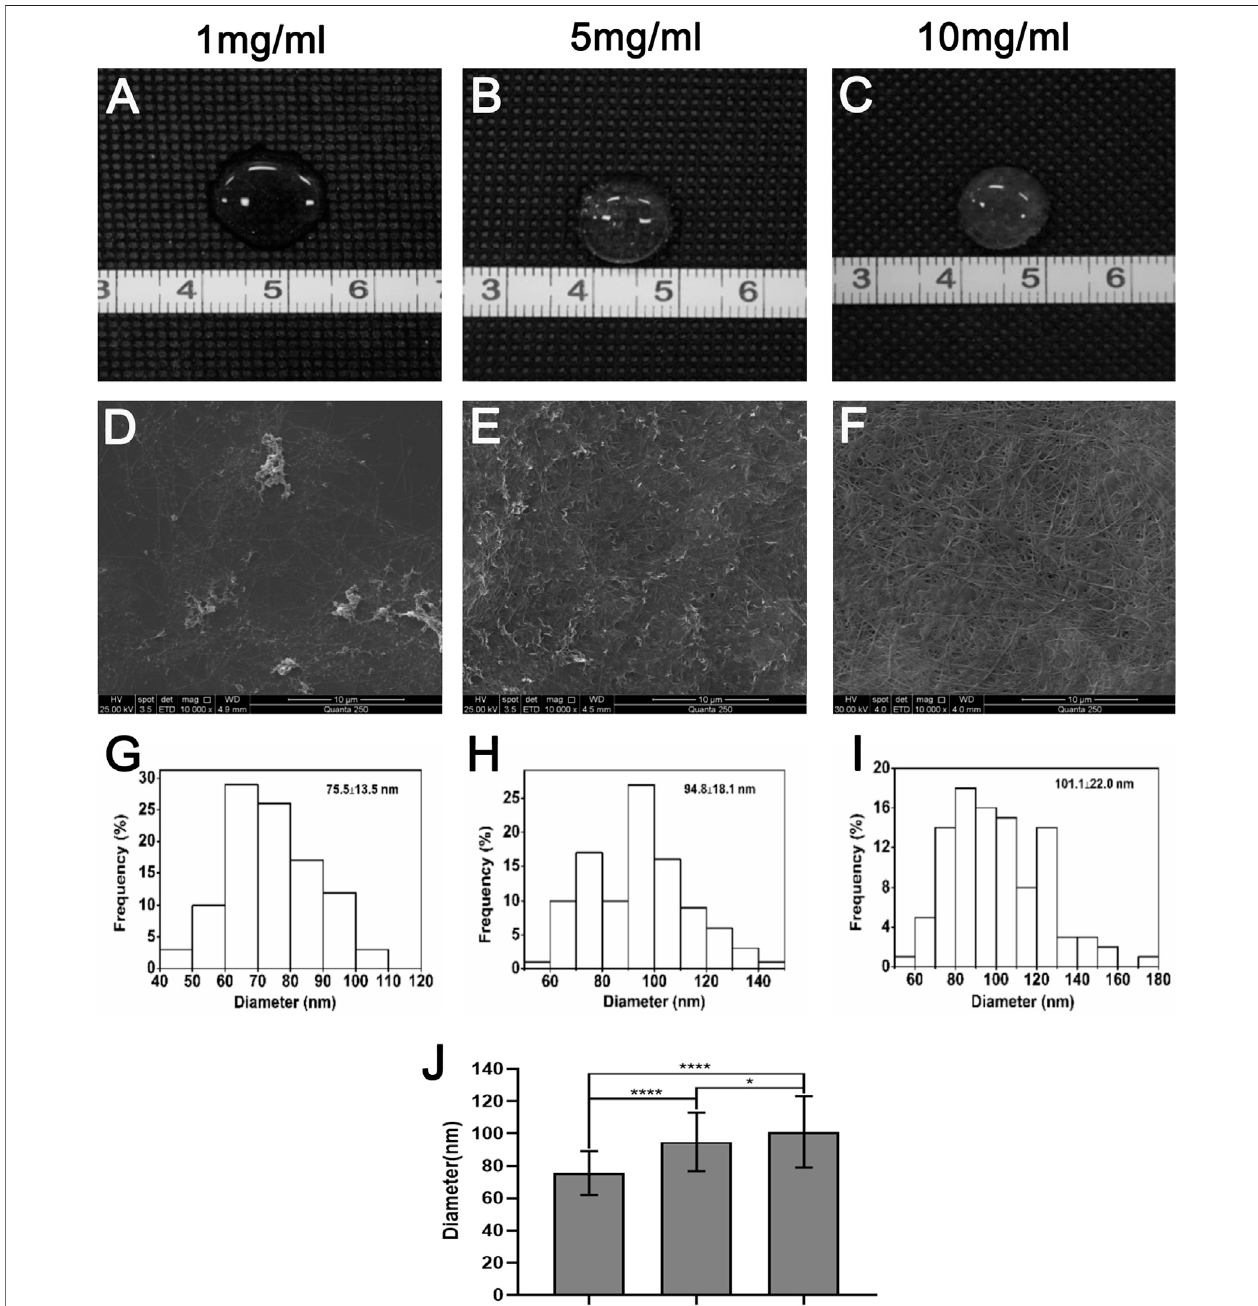
FIGURE 2 | Macroscopic appearance, scanning electron microscopy images and mechanical properties of dcECM hydrogels in vitro . (A – C) Macroscopic appearanceofthedcECMhydrogelsat (A) 1, (B) 5,and (C) 10 mg/ml. (D – F) ScanningelectronmicroscopymicrographsofthedcECMhydrogelsat (D) 1, (E) 5,and (F) 10 mg/ml (10,000 × ). (G – I) Distributions of fi ber diameters of (G) 1, (H) 5, and (I) 10 mg/ml dcECM hydrogels. (J) Comparisons of the fi ber diameters of the dcECM hydrogels at different concentrations. Error bars showed means ± SD, * p < 0.05, **** p < 0.0001, n (cid:2) 100.